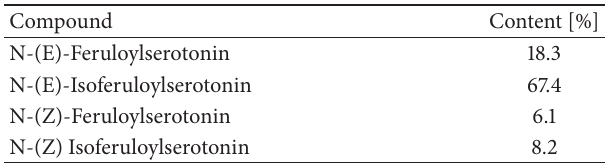
Table 1: Composition of the crystalline N-feruloylserotonin com- plex fraction, where the content of N-feruloyl- and N-isoferuloyl- (E = trans- and Z = cis-) serotonin isomers was determined by HPLC